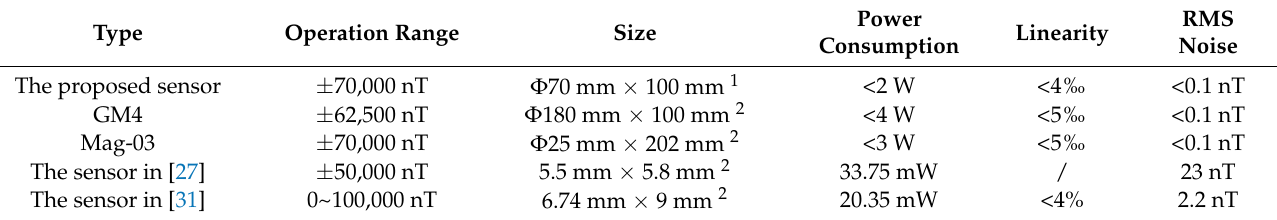
Table 4. Comparison between the proposed fluxgate sensor and other